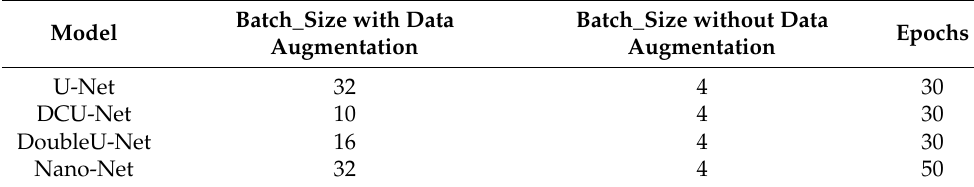
Table 2. Model training